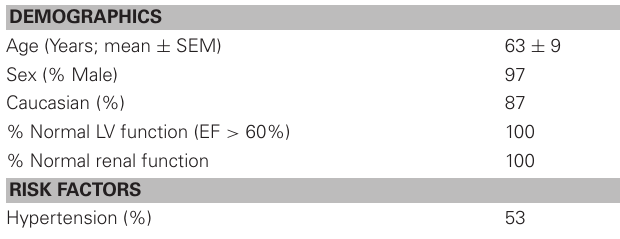
Table 1 | Characteristics and coronary lesion data of the study cohort ( n =